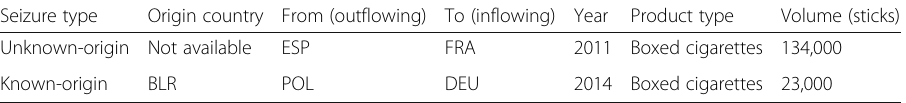
Table 2 Example of seizure data structure Seizure